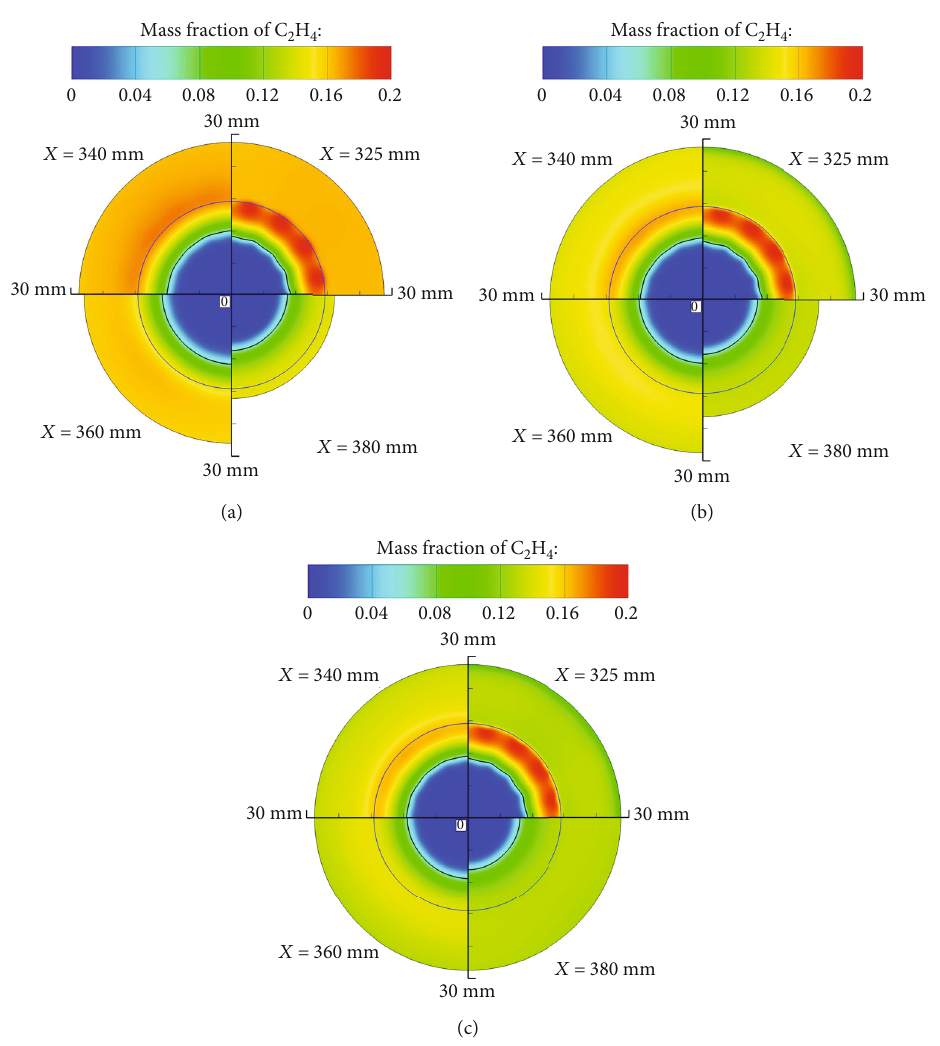
H contour for all cases in the nonreacting fl ow fi eld; the black and blue solid lines are the 2 4